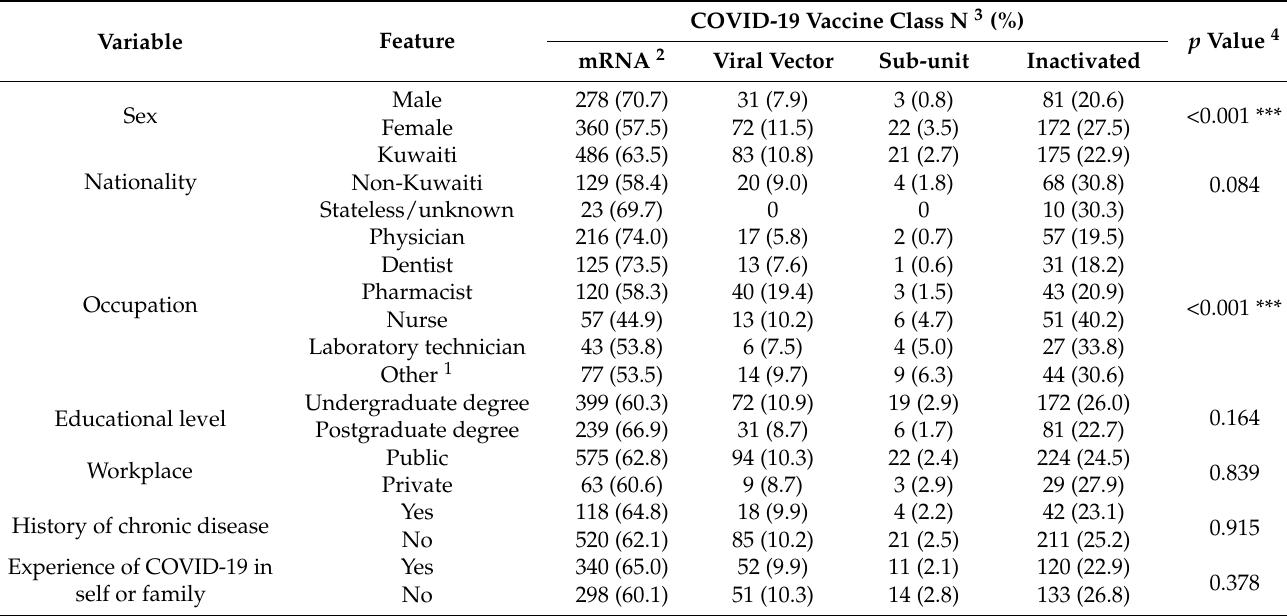
Table 4. Association of vaccine class preference with participants’ characteristics.